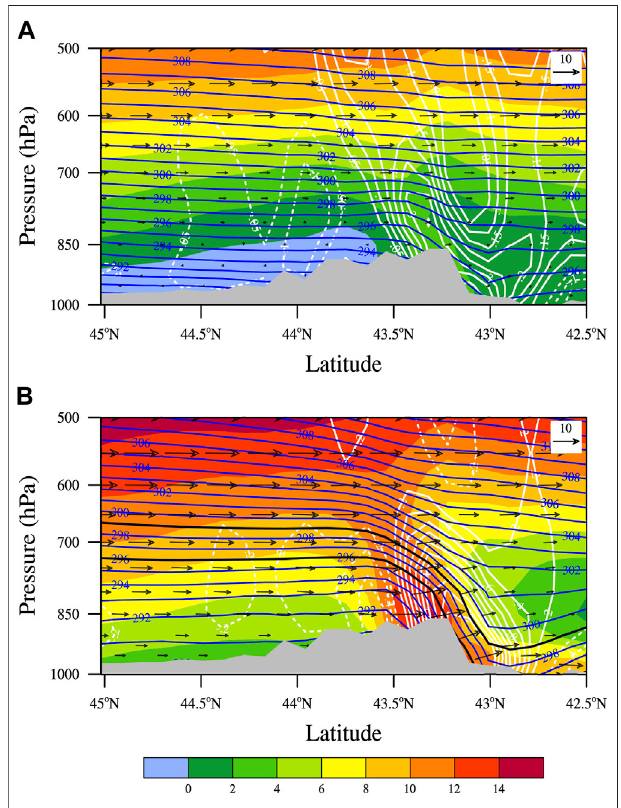
FIGURE 12 | Composite potential temperature (blue contours, unit: K), horizontal wind speed (shading, unit: m s − 1 ), vertical velocity (white contours, unit: Pa s − 1 ) and wind fi elds (vectors) in the vertical plane along line CD in Figure 11 in the two cases of (A) Low_Wind and (B) High_Wind.